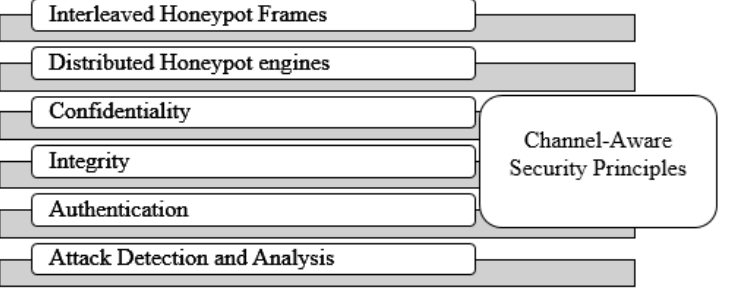
Figure 1. WIHFM ‐ Security Features. Figure 1. WIHFM-Security